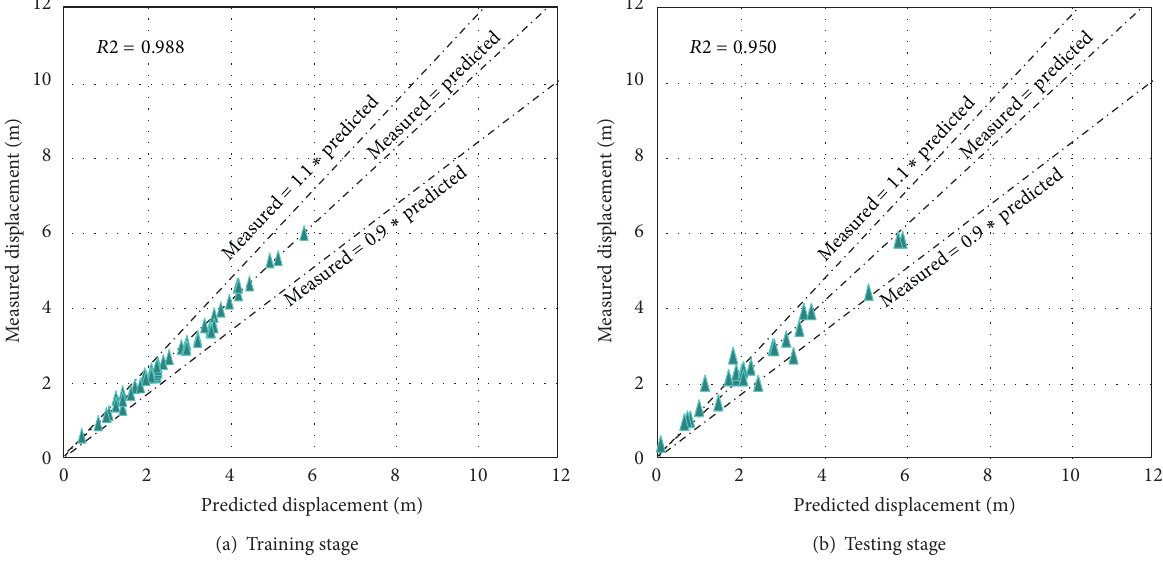
Figure 35: Comparison between NEFLAS and measured lateral spread, Nihonkai-Chubu, Japan. (a) Training stage and (b) testing stage.